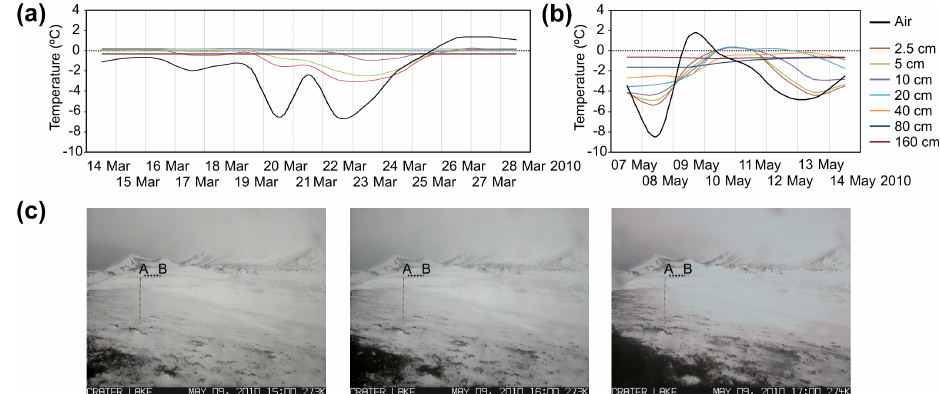
Figure 8. Air and ground temperature fluctuations on the event scale. (a) Event (I): brief surficial refreezing event from 14 to 28 March 2010. (b) Event (II): brief surficial thawing event from 7 to 14 May 2010. (c) Time-lapse camera photos at 11:00, 12:00 and 13:00 on 9